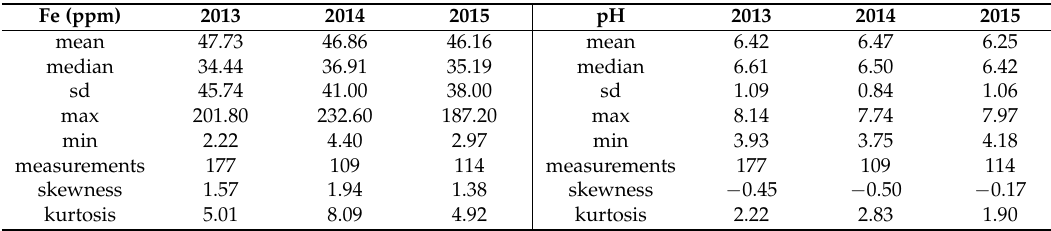
Table 1. Summary statistics of iron (Fe) in ppm and pH for every year.